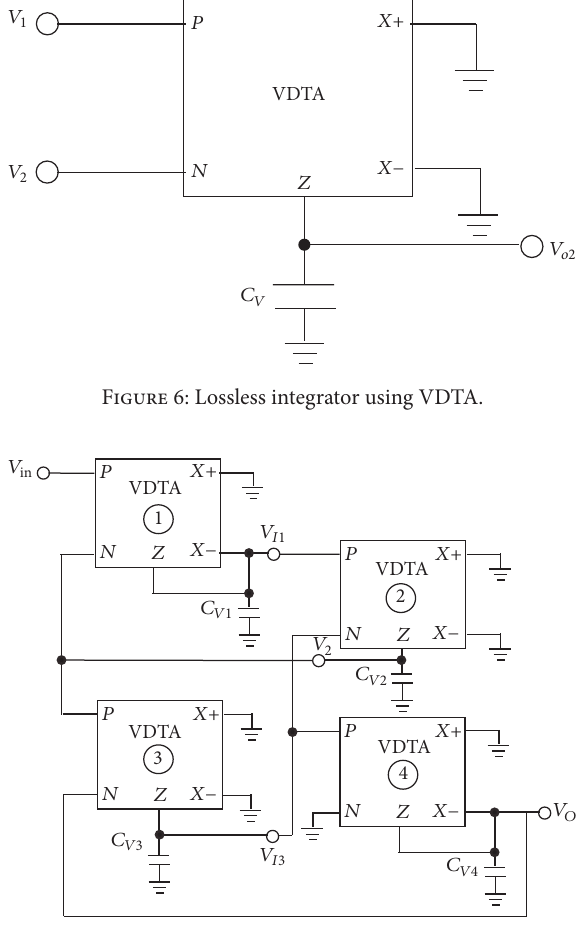
Figure 7: VDTA implementation of Figure 3 using operational simulation approach.